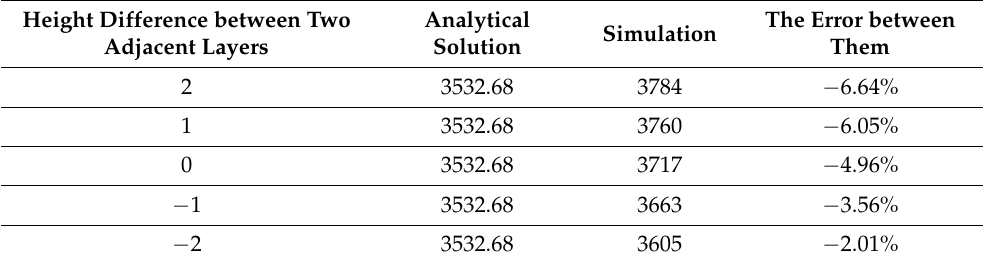
Figure 16. Relation curve of the column bottom bending moment with different story heights of the metro station. Table 2. The comparison between simulation and analytical solution within different heights of two layers.